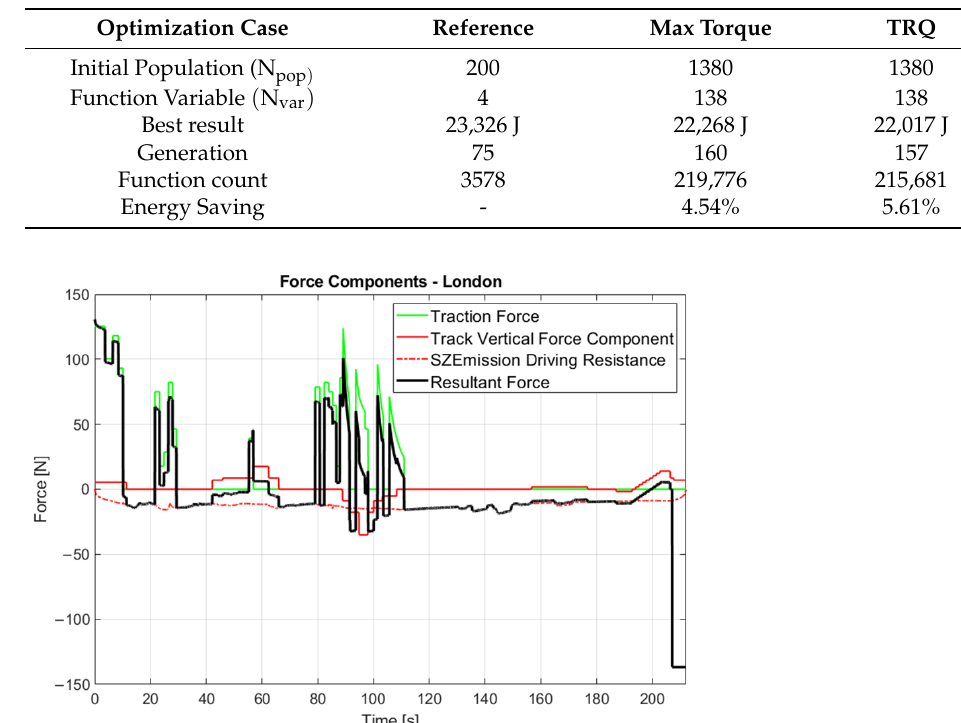
Table 4. Optimization parameters and results for London Track. Figure 11. Track optimization results for London Track; ( a ) speed profile; ( b ) energy consumption.